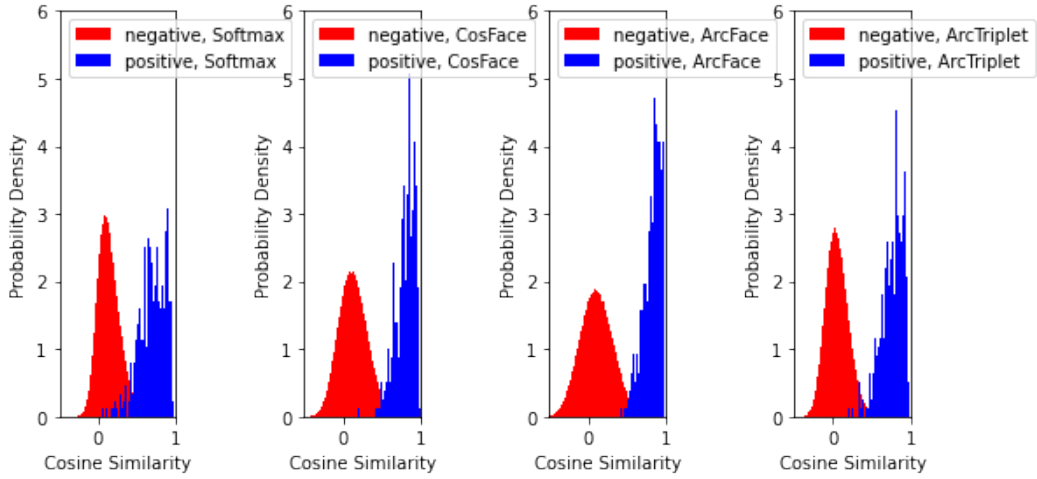
Figure 7. ROC curve of ArcFace + Triplet loss on CASIA-Iris-Thousand.